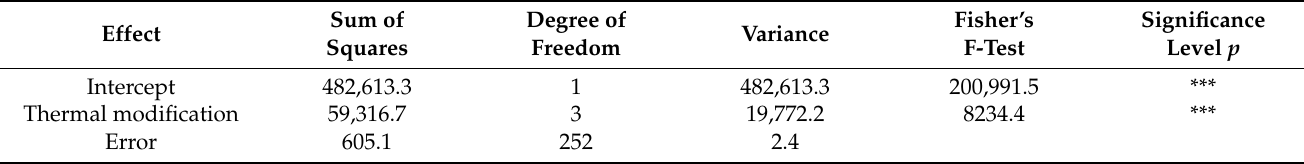
Table 3. Statistical evaluation of the factors affecting the change in the L * value.